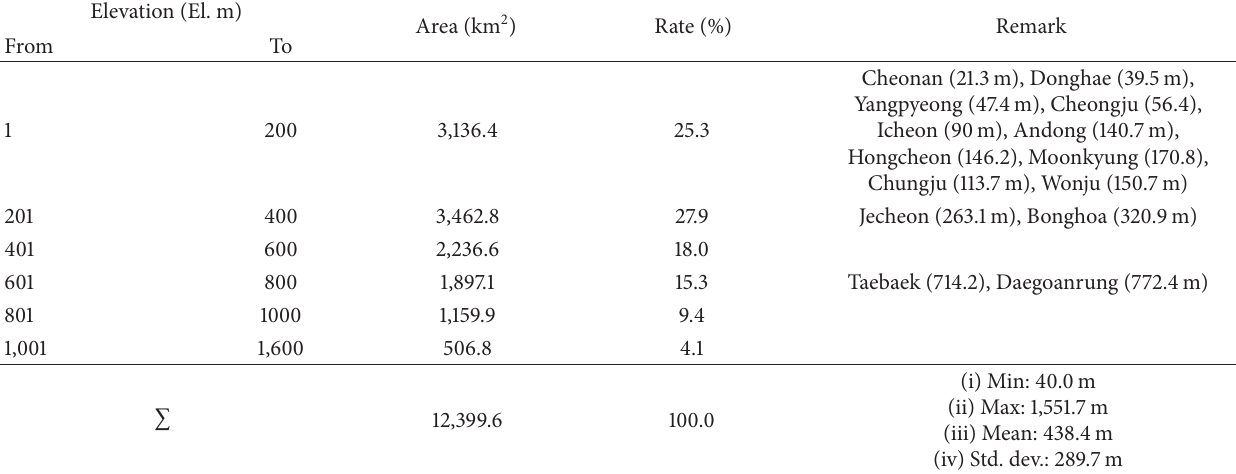
Table 5: Geomorphologic characteristics of the Namhan river basin.